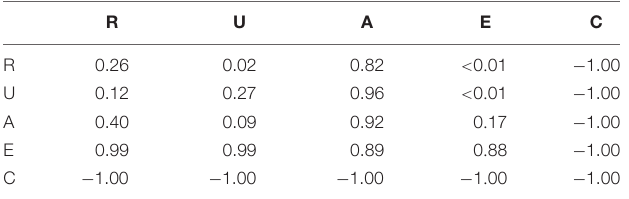
TABLE 8 | Adjust residuals of effective single sequences in the first and second team in five debates.